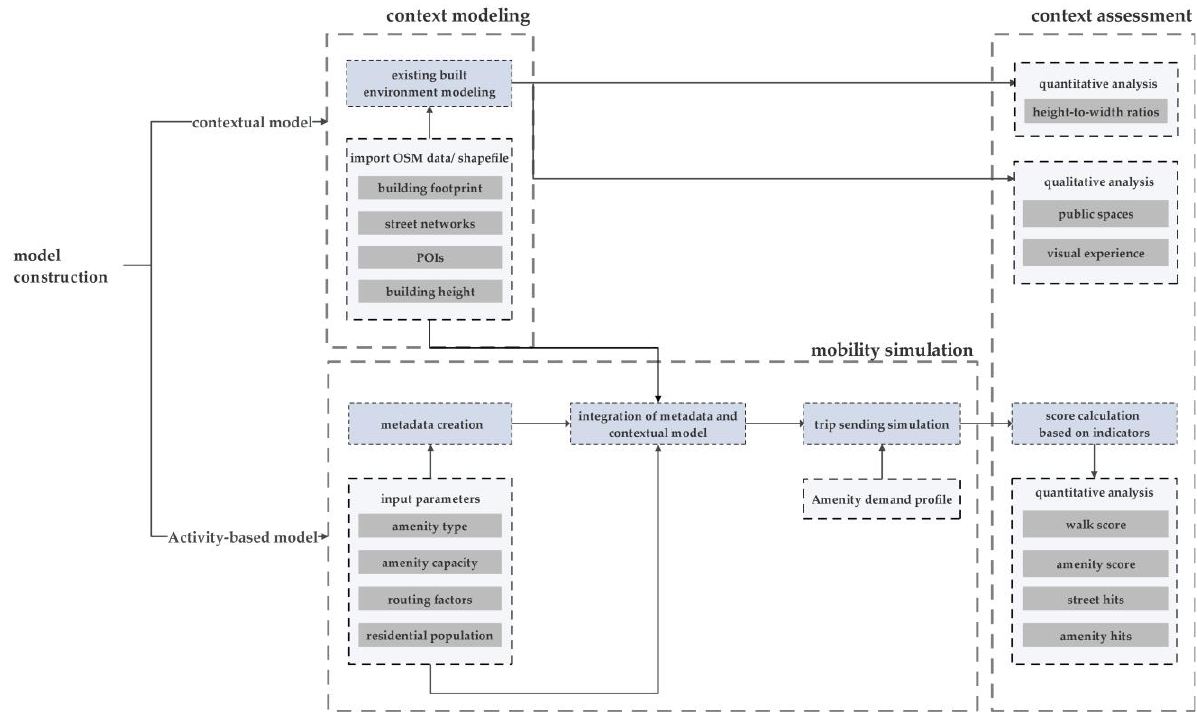
Figure 1. The workflow of context modeling and assessment. Table 2. The details of input parameters of context modeling and assessment.